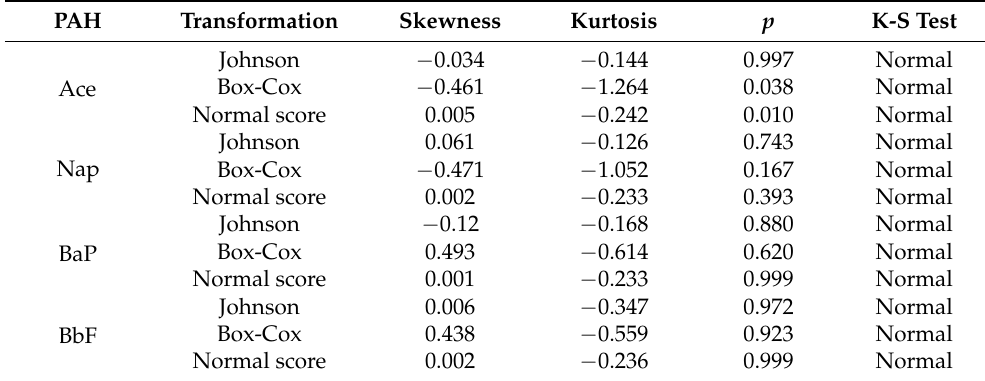
Figure 1. Left : Blot plots of soil Ace ( a1 ), Nap ( b1 ), BaP ( c1 ), and BbF ( d1 ) concentrations. Right : His- tograms of soil Ace ( a2 ), Nap ( b2 ), BaP ( c2 ), and BbF ( d2 ) concentrations. Table 2. Summarized statistics of the transformed soil PAHs concentrations.